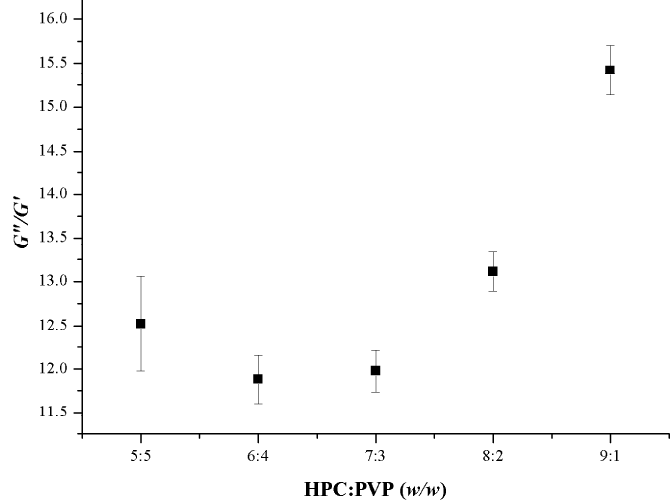
Figure 2. Ratio of loss ( G ”) and storage ( G ’) moduli of furosemide-loaded gels as a function of HPC-PVP mass ratio (oscillatory shear measurements at a frequency 1.995 Hz).